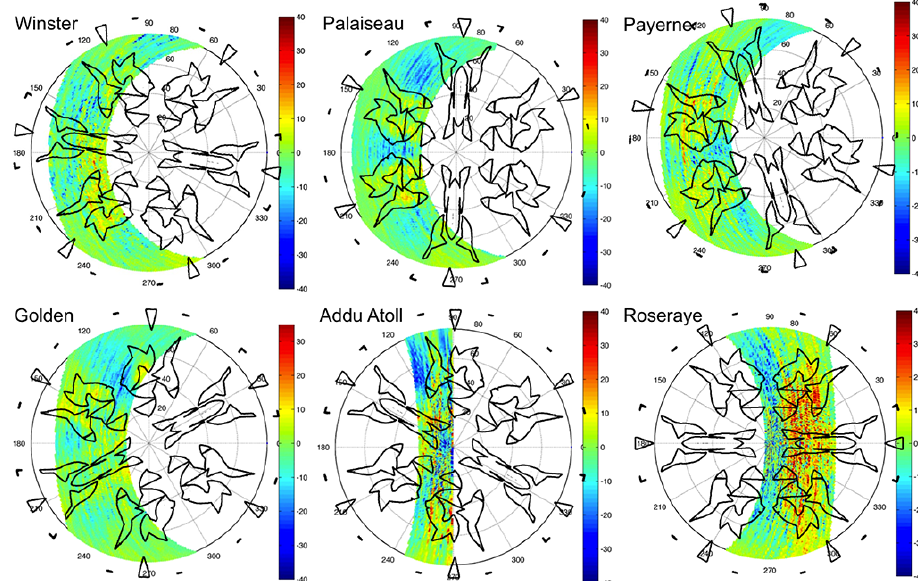
Figure 10. DHI differences (TBM – SPN1) as in Fig. 9 with the 10 ◦ first-touch-angle isolines superimposed for all sites. SPN1 values have been recalibrated as described in Sect.